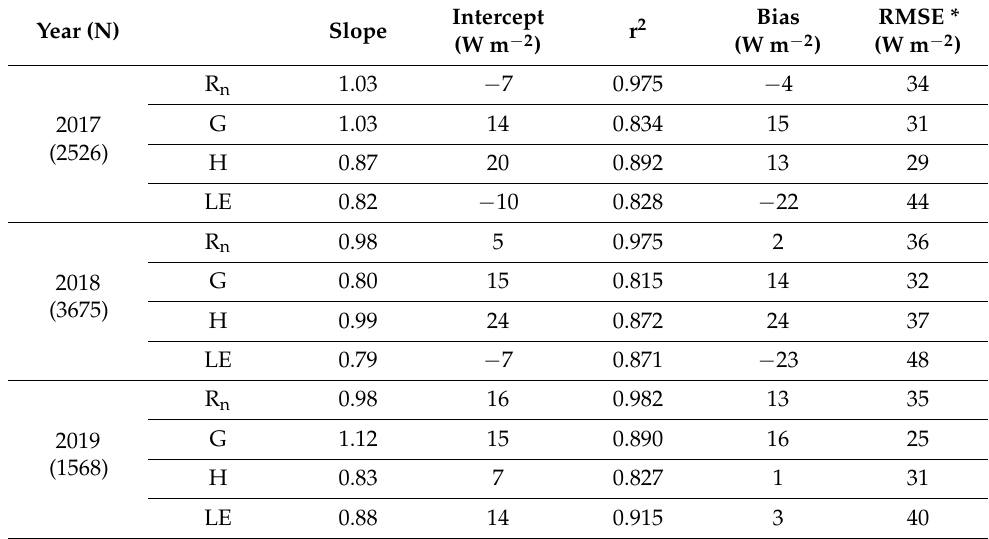
Table 2. Statistics of the linear regressions between modeled and observed hourly values of the surface energy fluxes: net radiation (R n ), soil heat flux (G), sensible heat flux (H) and latent heat flux (LE).